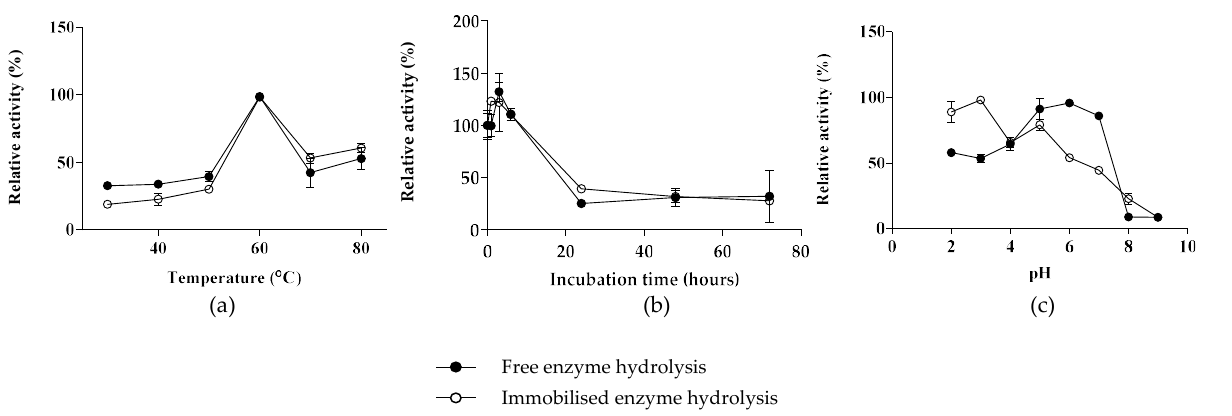
Figure 3. ( a ) Temperature optimum (30–80 °C), ( b ) thermostability (0–72 h), and ( c ) pH optimum study of immobilised (9.14 U/mg) and free (44.05 U/mg) endo-1,4-β-mannanase under hydrolysis with 0.5% ( w / v ) LBG (30-min, 55 °C).